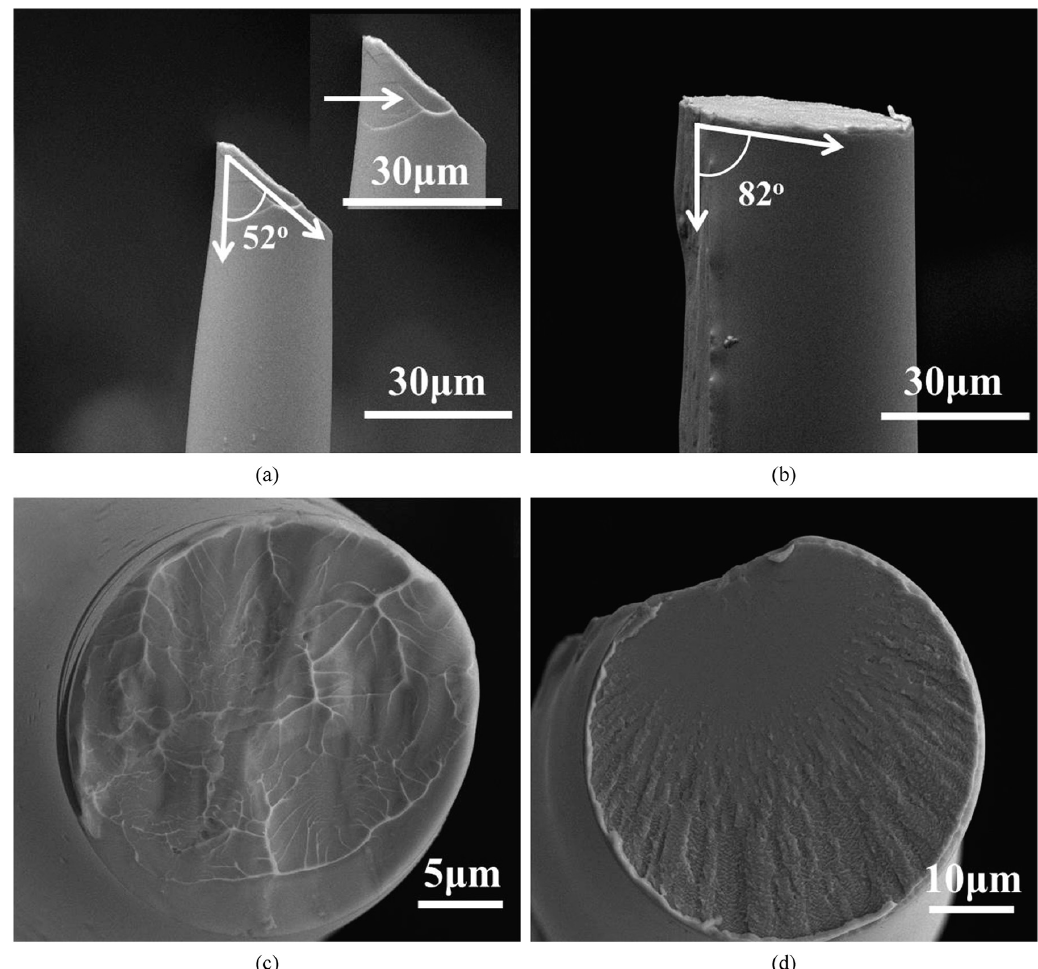
Figure 5. Fracture morphologies of melt-extracted Gd local magnified image of (a)) and (b) ~40 μm for side-view. (c) and (d) show the cross-section images of (a) and